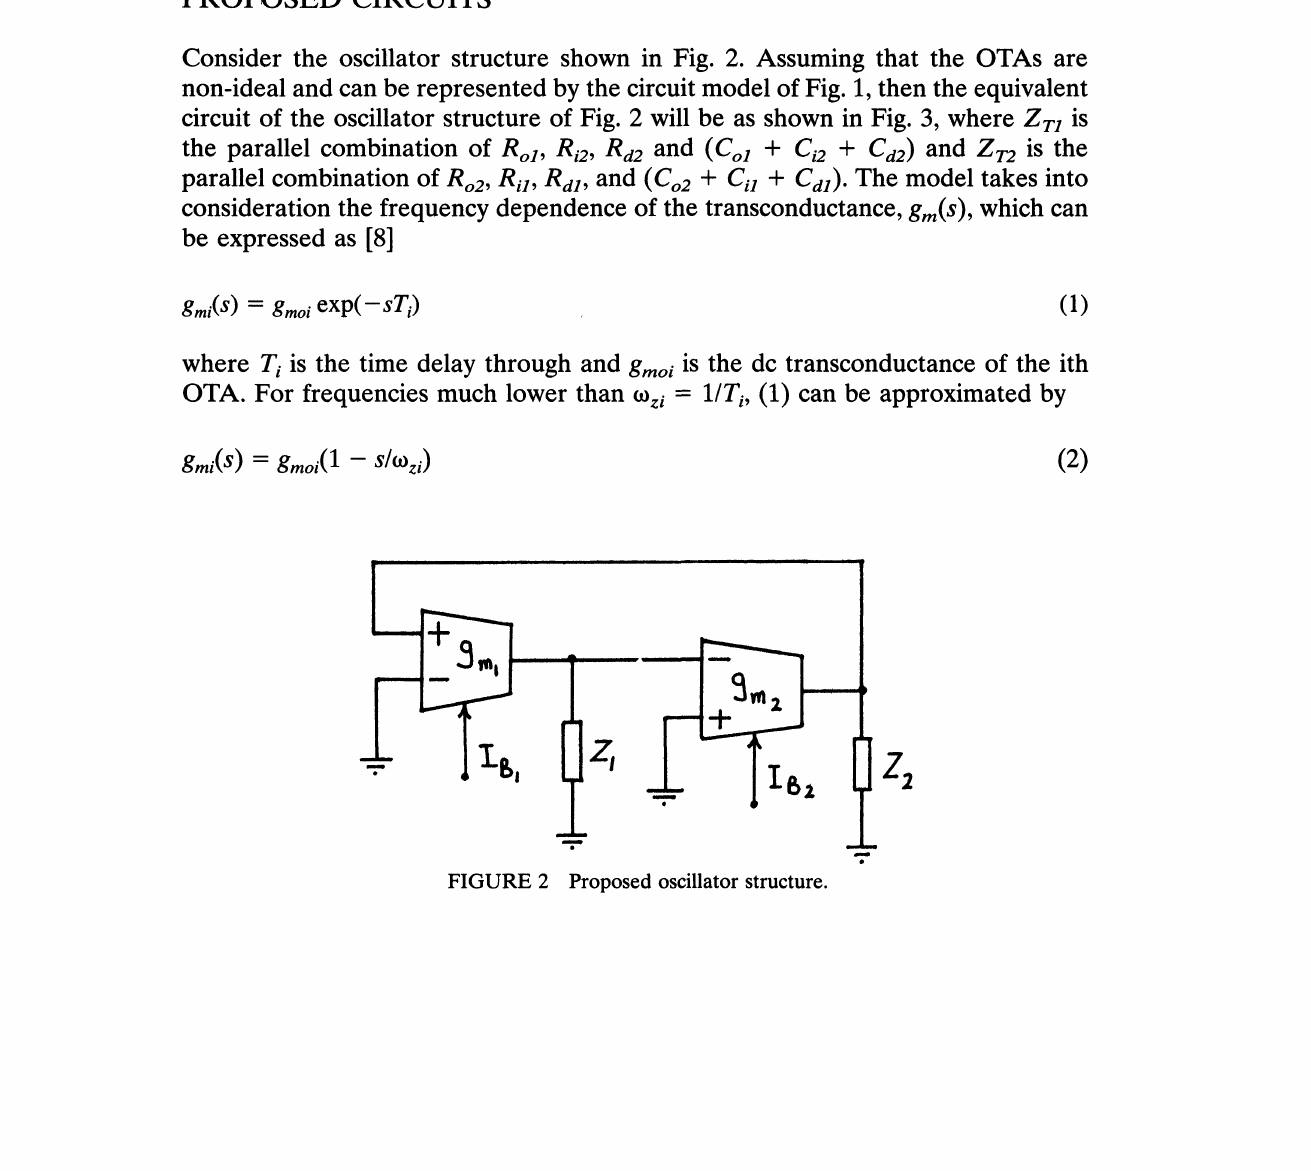
FIGURE 1 Circuit symbol (a) and circuit model (b) of a nonideal OTA operating in the linear region.